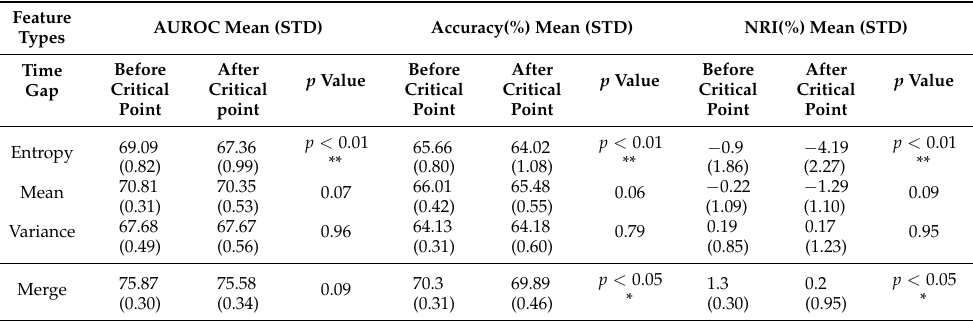
Figure 6. Visualization plot for time gap variance F value from F test on AUROC. As 30 h was the critical point of time between slight AKI signs and rapid AKI oscilla- tion, as shown in in Tables 9 and 10 , we conducted a comparison between using a time gap of less than 30 h (after critical point, rapid AKI oscillation) and a time gap of more than 30 h (before critical point, slight AKI signs). Statistically significant differences ( p < 0.01) were observed in and V entropy in AUROC; V entropy and V merge inaccuracy, NRI and precision. V entropy and V mean in Recall Table 9. Comparison between using a time gap of less than 30 h (rapid AKI oscillation) and a time gap greater than 30 h (slight AKI signs) on AUROC, Accuracy and NRI.